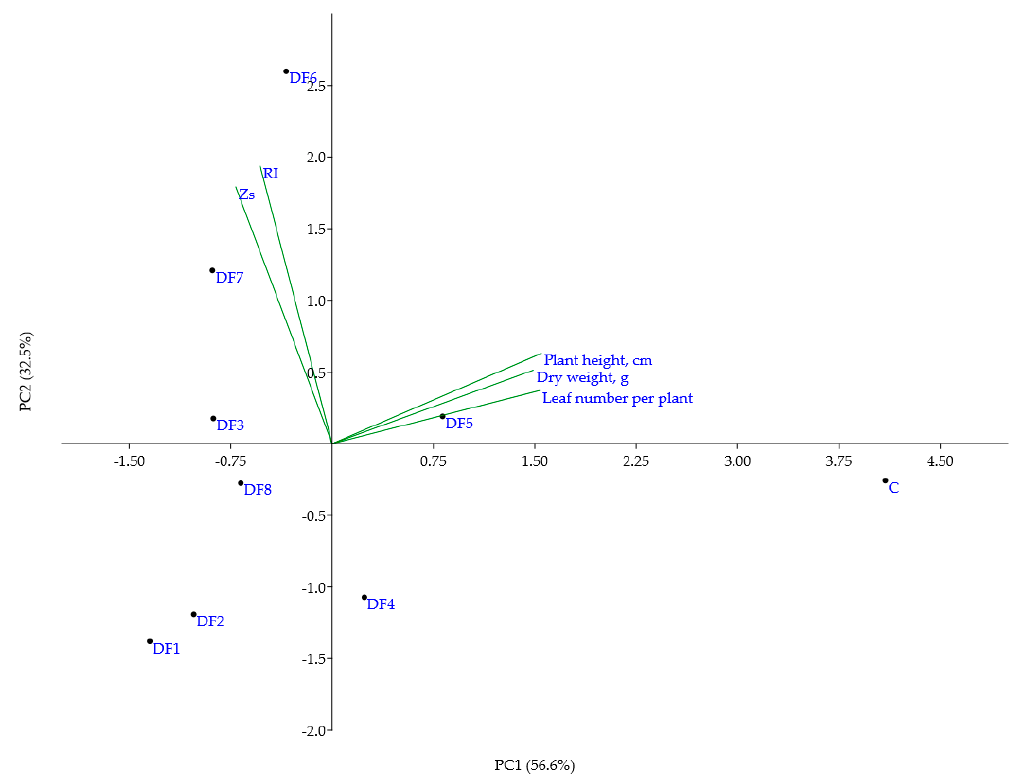
Figure 1. Results of PCA using quantitative characteristics of broad bean plants grown in polluted soils with different extents of heavy metal pollution. DF1–DF8—polluted soil from different sites of the drill factory.